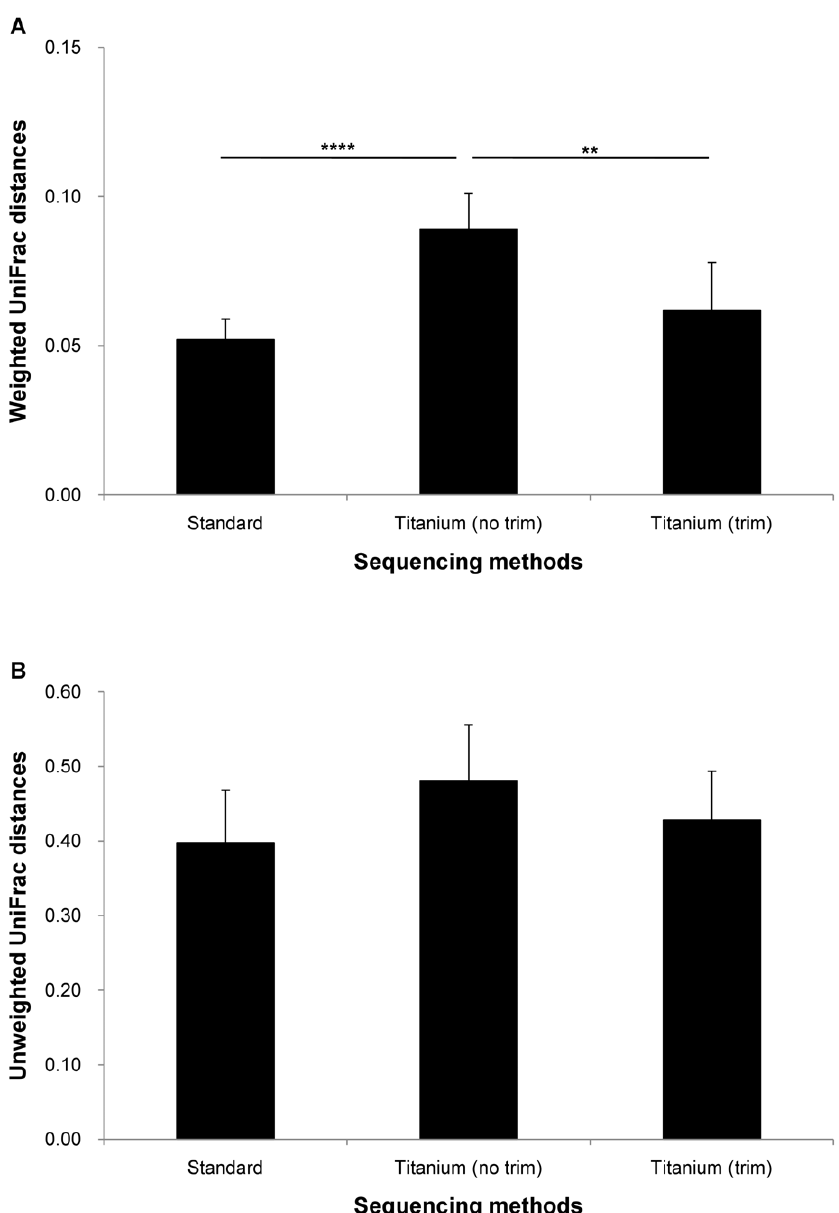
Figure 3. UniFrac distances between sequencing methods. (A) Weighted and (B) unweighted UniFrac distances. Reads by 454 Standard chemistry were compared with technical replicates of the same DNAs sequenced by 454 Standard chemistry (Standard), with 454 Titanium chemistry (no trim), and with 454 Titanium chemistry with sequences trimmed at 270 bp (trim). ** p , 0.01, **** p , 0.0001